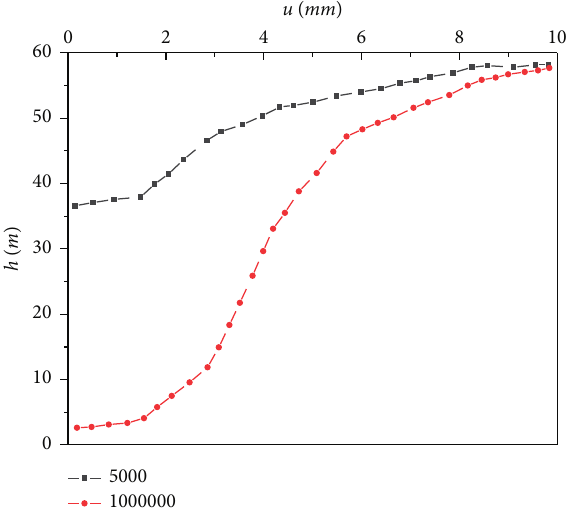
Figure 23: Permanent deformation diagram of the cross section of the subgrade.